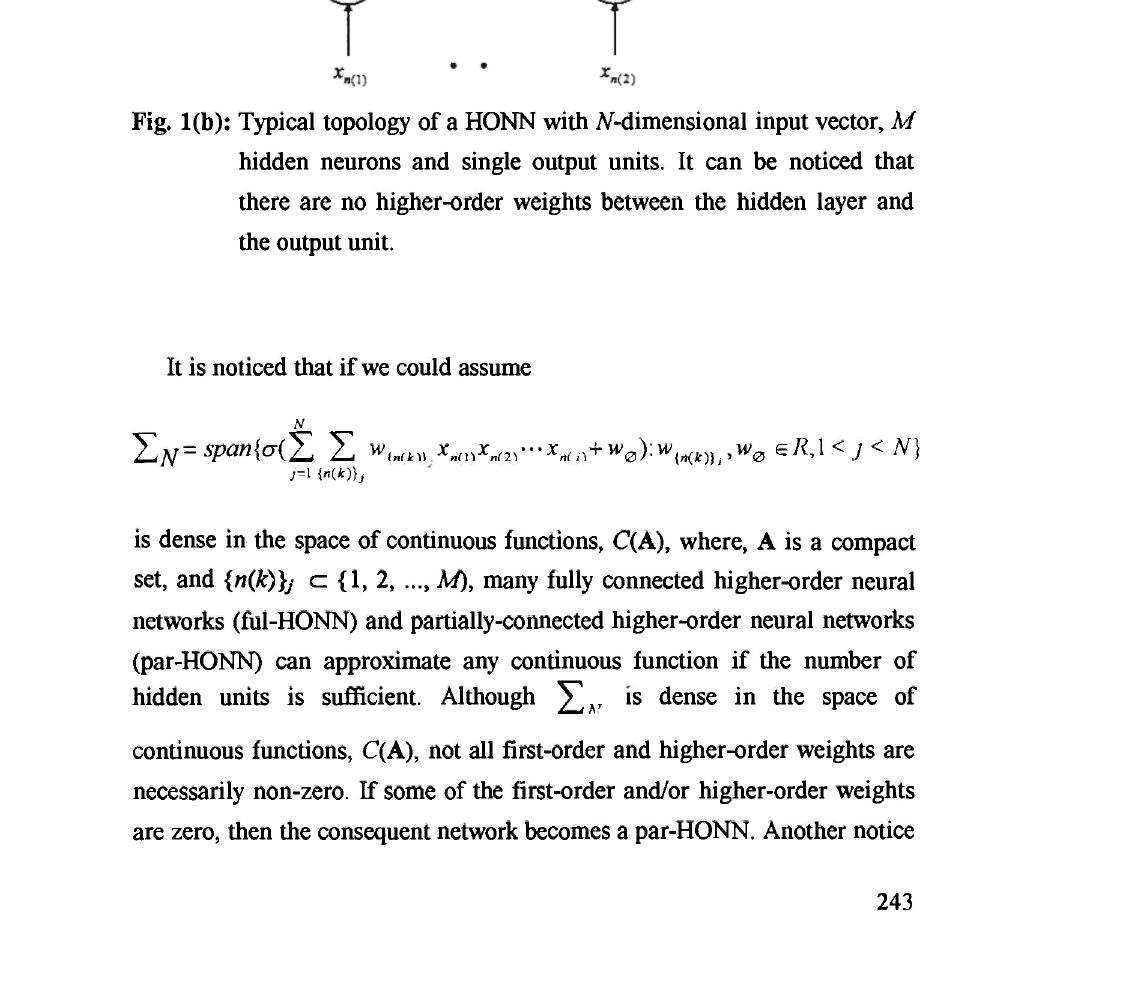
Fig. 1(b): Typical topology of a HONN with N-dimensional input vector, Μ hidden neurons and single output units. It can be noticed that there are no higher-order weights between the hidden layer and the output